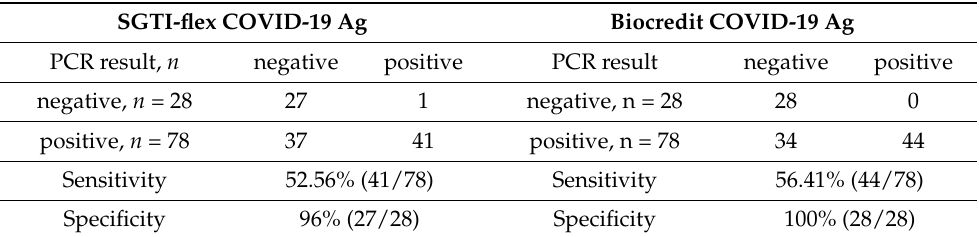
Table 2. Assessment of sensitivity and specificity of rapid tests compared to